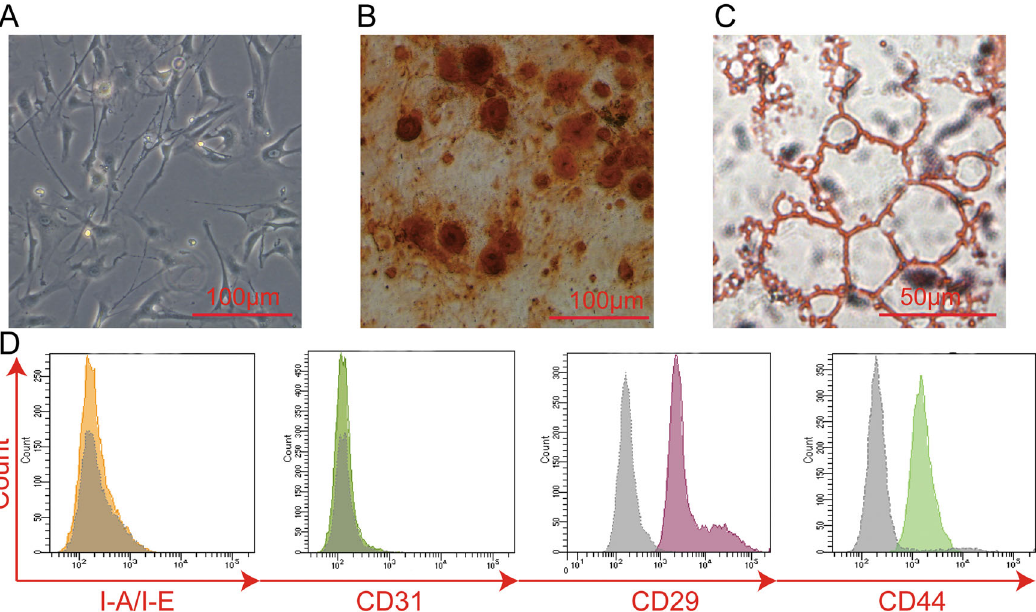
Fig. 1 Isolation and characterization of adipose-derived mesenchymal stem cells. Stem cell pro fi les of in vitro cultured ADSCs from mice were evaluated through differentiation assays. A The ADSC bright- fi eld photos were taken using a light microscope. B , C Stem cell pluripotency was evaluated by culture osteogenesis and adipogenesis under differentiation stimuli and posterior staining with ( B ) Alizarin Red and ( C ) Oil Red. Histograms for stem cell marker expression ( D ) in ADSCs (CD44, CD29 positive; I-A/I-E, CD31 negative) were obtained with a cytometric analysis. Gray plots represent the negative control, while other colored plots represent the surface marker antibody ‑ stained